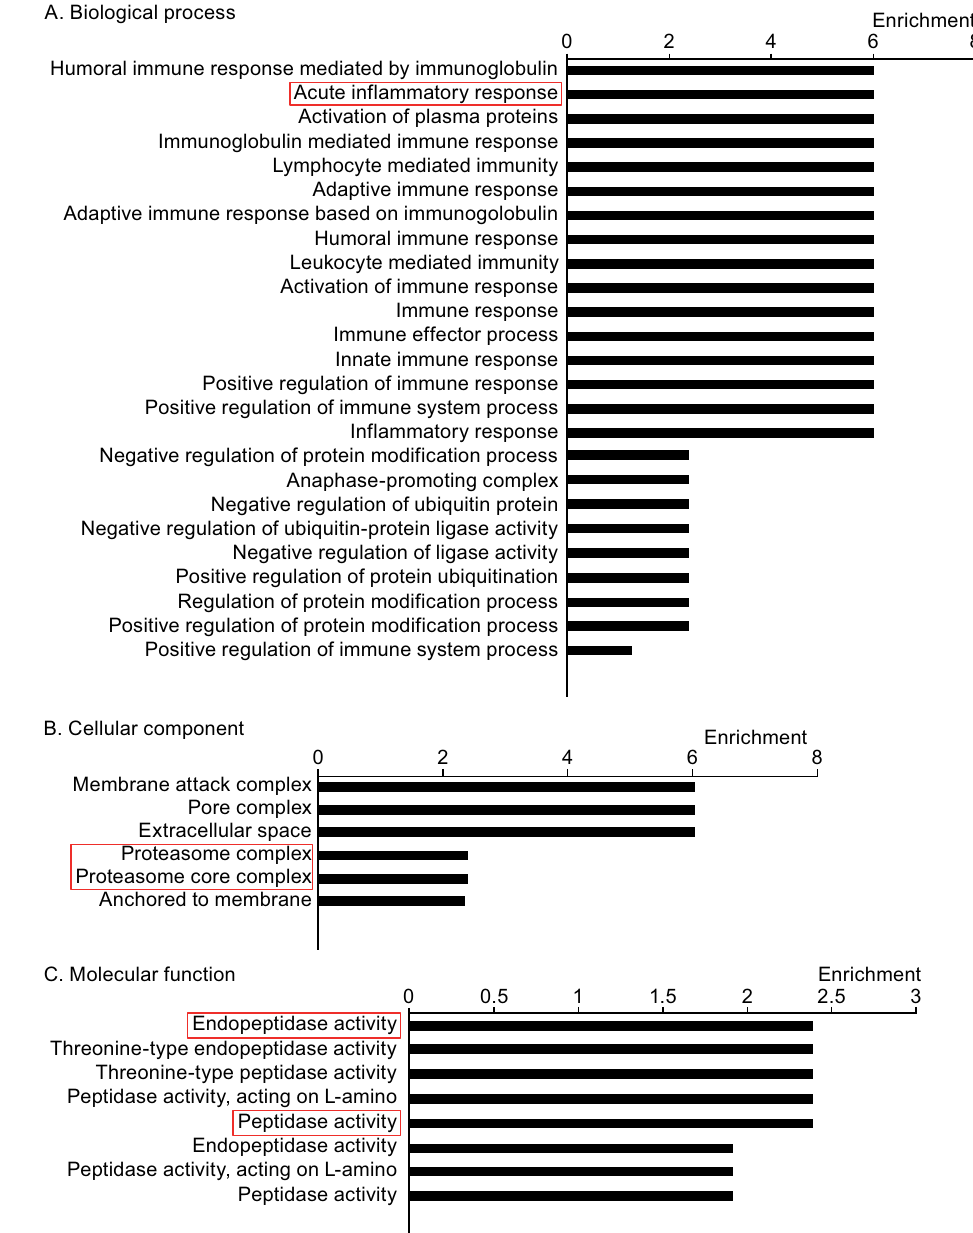
Figure 3. GO analysis of 63 genes. (A – C) GO analysis of the total 63 differentially expressed proteins was based on the shotgun proteomic results in the aspects of biological process, cellular component, and molecular function. Some highly enriched terms such as acute in fl ammatory response, proteasome complex, endopeptidase activity etc. were associated with in fl ammatory bowel